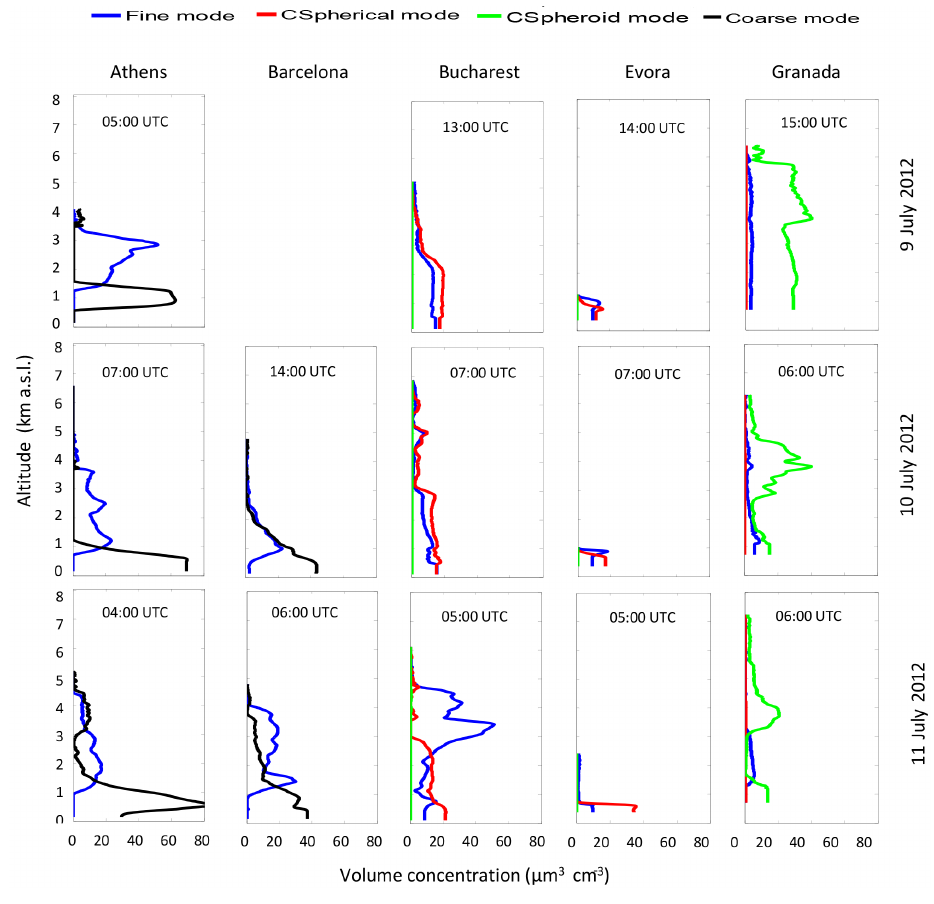
Figure 4. Volume concentration profiles of the total coarse mode and the fine mode at Barcelona and Athens, and volume concentration profiles of fine, coarse spherical, and coarse spheroid modes at Évora, Bucharest, and Granada (from left to right) for different periods of 9, 10, and 11 July 2012 (from top to bottom).